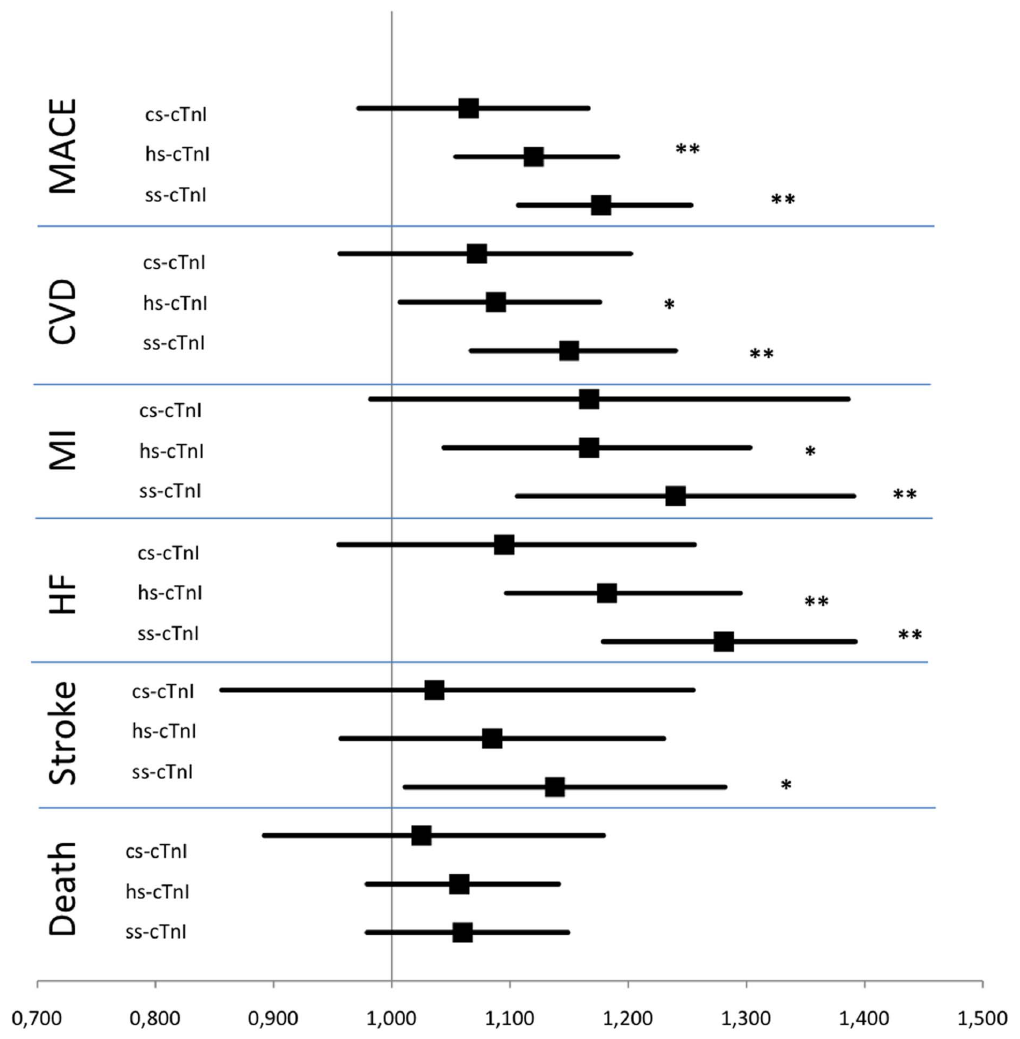
Figure 2. Hazard Ratios from Cox Regression Models for Baseline Troponin Assessed by Contemporary-Sensitivity, High-Sensitivity and Super-Sensitivity Assays for Various Endpoints after Adjustment for the Framingham Risk Score. **=p value , 0.001, *= p value , 0.05. MACE=major adverse cardiac events, CVD=cardiovascular disease, MI=myocardial infarction, HF=heart failure, HR=hazard ratio, CI=confidence interval, cs-cTnI=troponin I measured by contemporary-sensitivity assay, hs-cTnI=troponin I measured by high-sensitivity assay, ss- cTnI=troponin I measured by super-sensitivity assay.